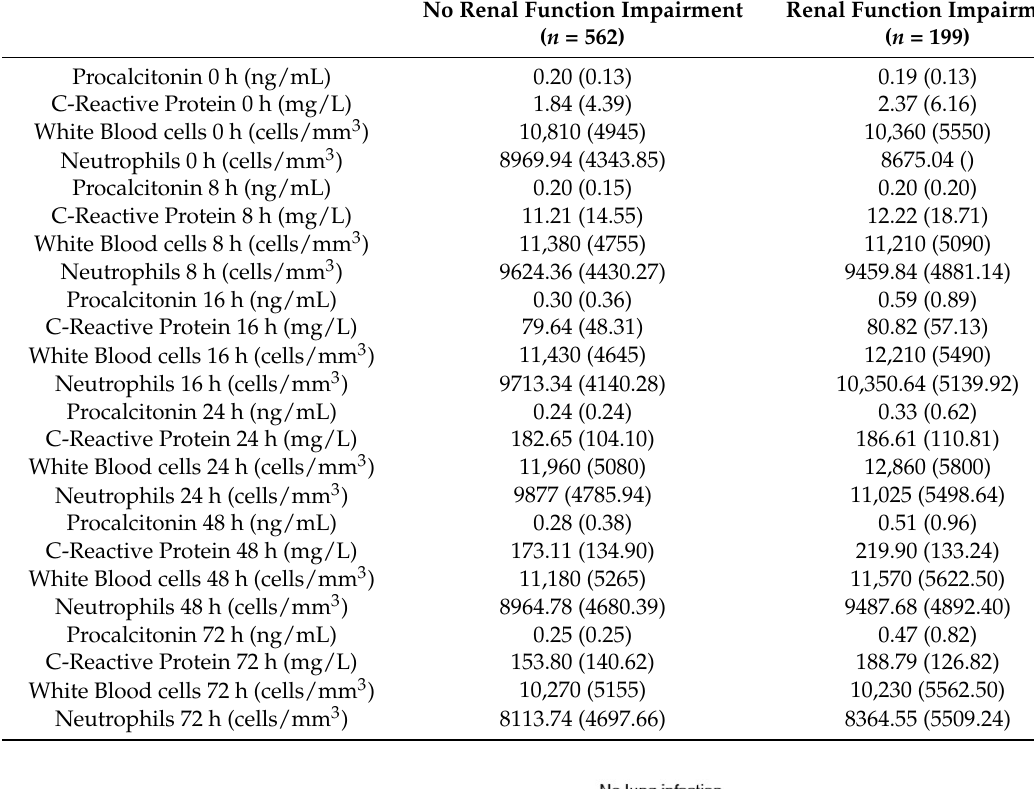
Table 3. Biomarker levels based on the presence/absence of renal function impairment over time in patients without lung infection. Biomarkers are represented as median and interquartile range (IQR). p values < 0.05 are highlighted in bold.